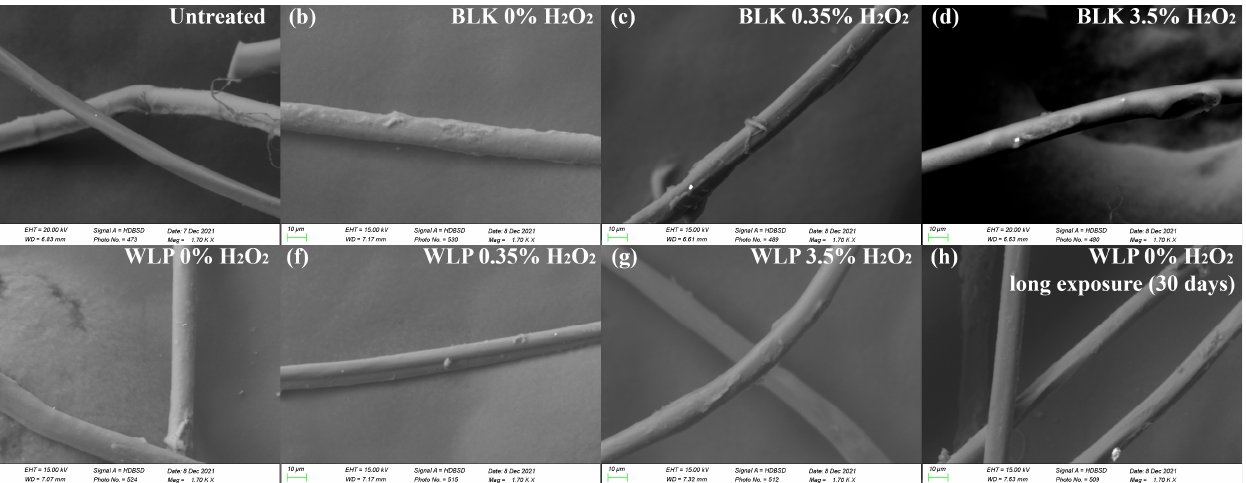
Table 4. Fiber diameter.